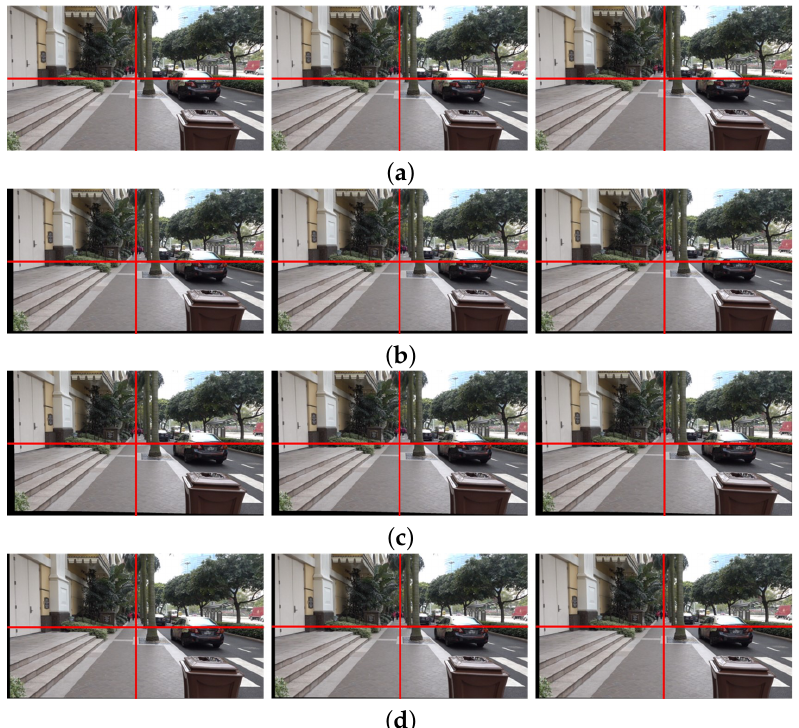
Figure 10. Experimental results of various video stabilization methods: ( a ) the input shaky video frames (170th, 171st, and 172nd frames), ( b ) the stabilized video using the global camera path using feature detection [7], ( c ) the bundled path algorithm [14], and ( d ) the proposed